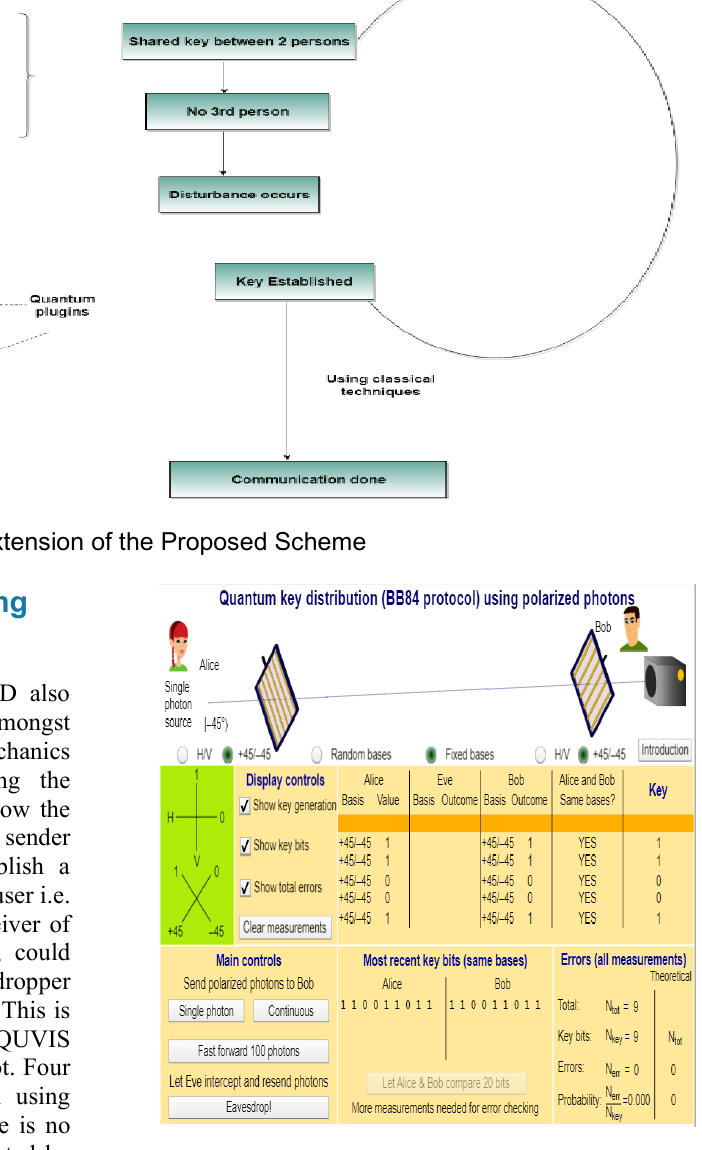
Figure 5. Simulations without